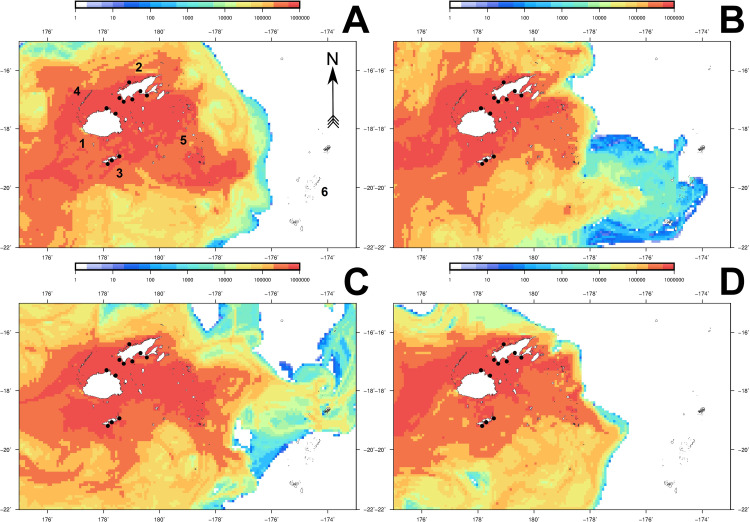
Cumulative particle count heat maps for 2014 and 2015 datasets (ENSO years).Final (day 60) particle counts are shown for spawning seasons 1 (A) and 2 (B) for 2014, and seasons 1 (C) and 2 (D) for 2015. Black circles denote the positions of spat collector deployments described by Kishore et al. [22]. The colour legend indicates the cumulative particle visit count within individual 10Km2 grid cells. Numbers denote the following localities: Viti Levu (1), Vanua Levu (2), Kadavu (3), Yasawa archipelago (4), Lau archipelago (5) and the Kingdom of Tonga (6).